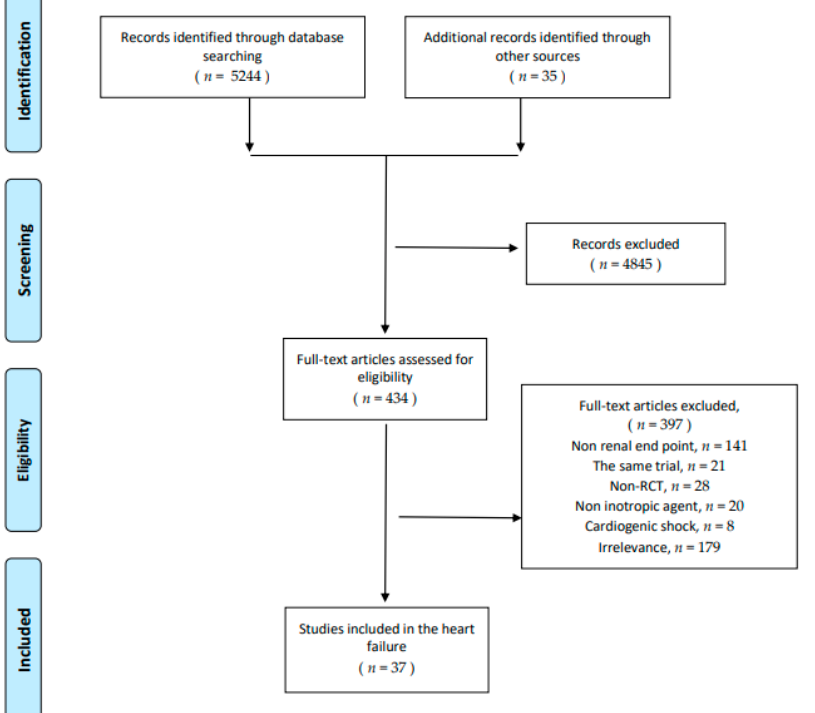
Figure 1. Preferred reporting items for systematic reviews and meta-analyses (PRISMA) flow diagram of randomized controlled trials, included and excluded.